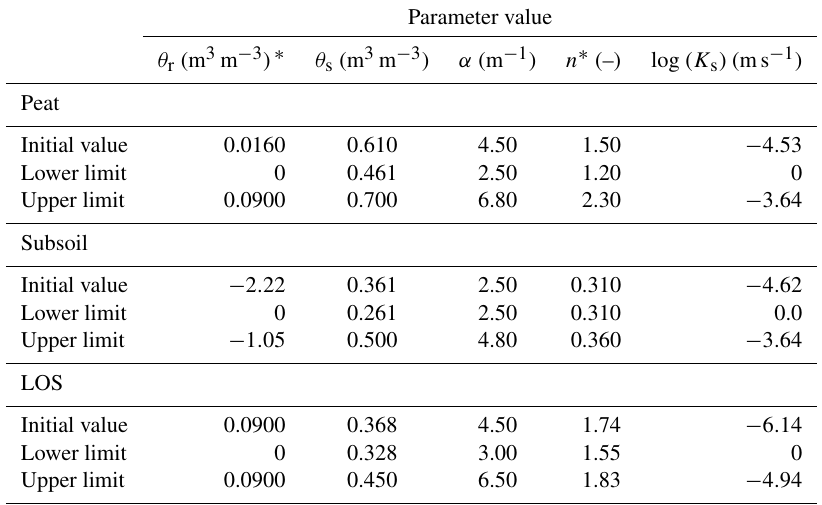
Table 1. Initial value and lower and upper limits of the five soil hydraulic parameters for TRT 10 (cell no. 23 in 2013) used in the inverse modelling to optimize parameters for peat, subsoil, and